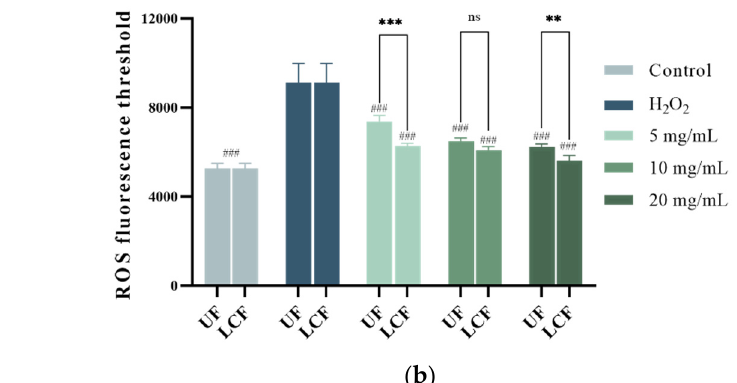
Figure 6. Effects of UF and LCF on ROS level: ( a ) H 2 O 2 -induced ROS production in cells; ( b ) intracellular DCFH-DC fluorescence threshold. UF: unfermentation; LCF: single microbial fermentation with L. curvatus . Analysis of significant differences between each group and H 2 O 2 model group; ###: p < 0.001; ns : p > 0.05.comparison of each group between UF and LCF, **: p < 0.01;